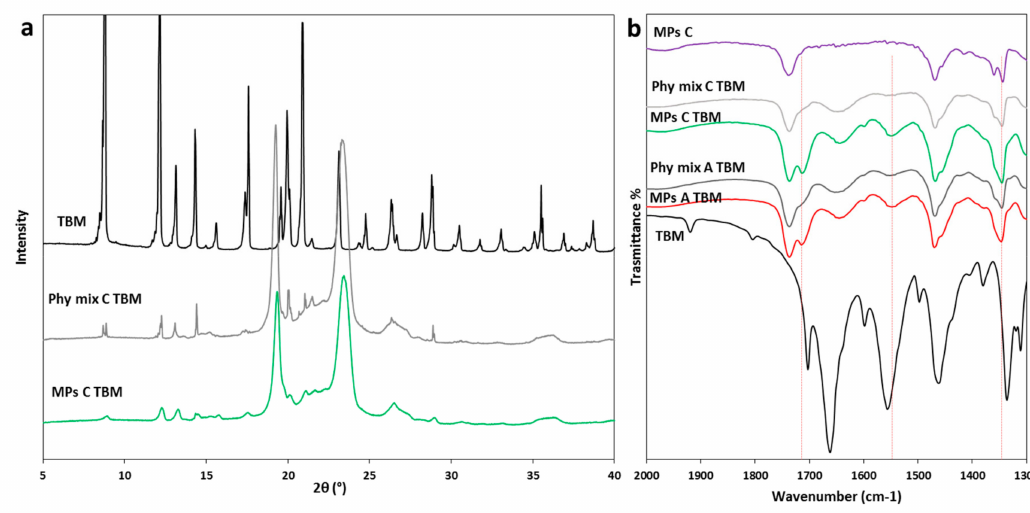
Figure 7. ( a ) XRPD spectra of TBM, Phy mix C TBM, and MPs C TBM; ( b ) FT-IR spectra of TBM, MPs A TBM, Phy mix A TBM, MPs C TBM, Phy mix C TBM and unloaded MPs C in the spectral